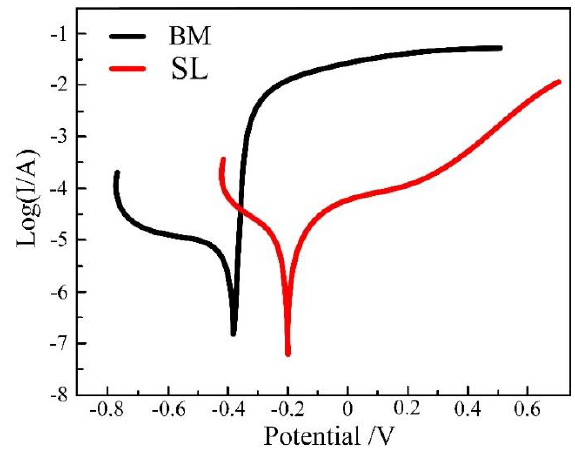
Figure 8. Polarization curve of the surfacing layer. Table 3. Corrosion parameters of low carbon steel, surfacing layer, and fusion